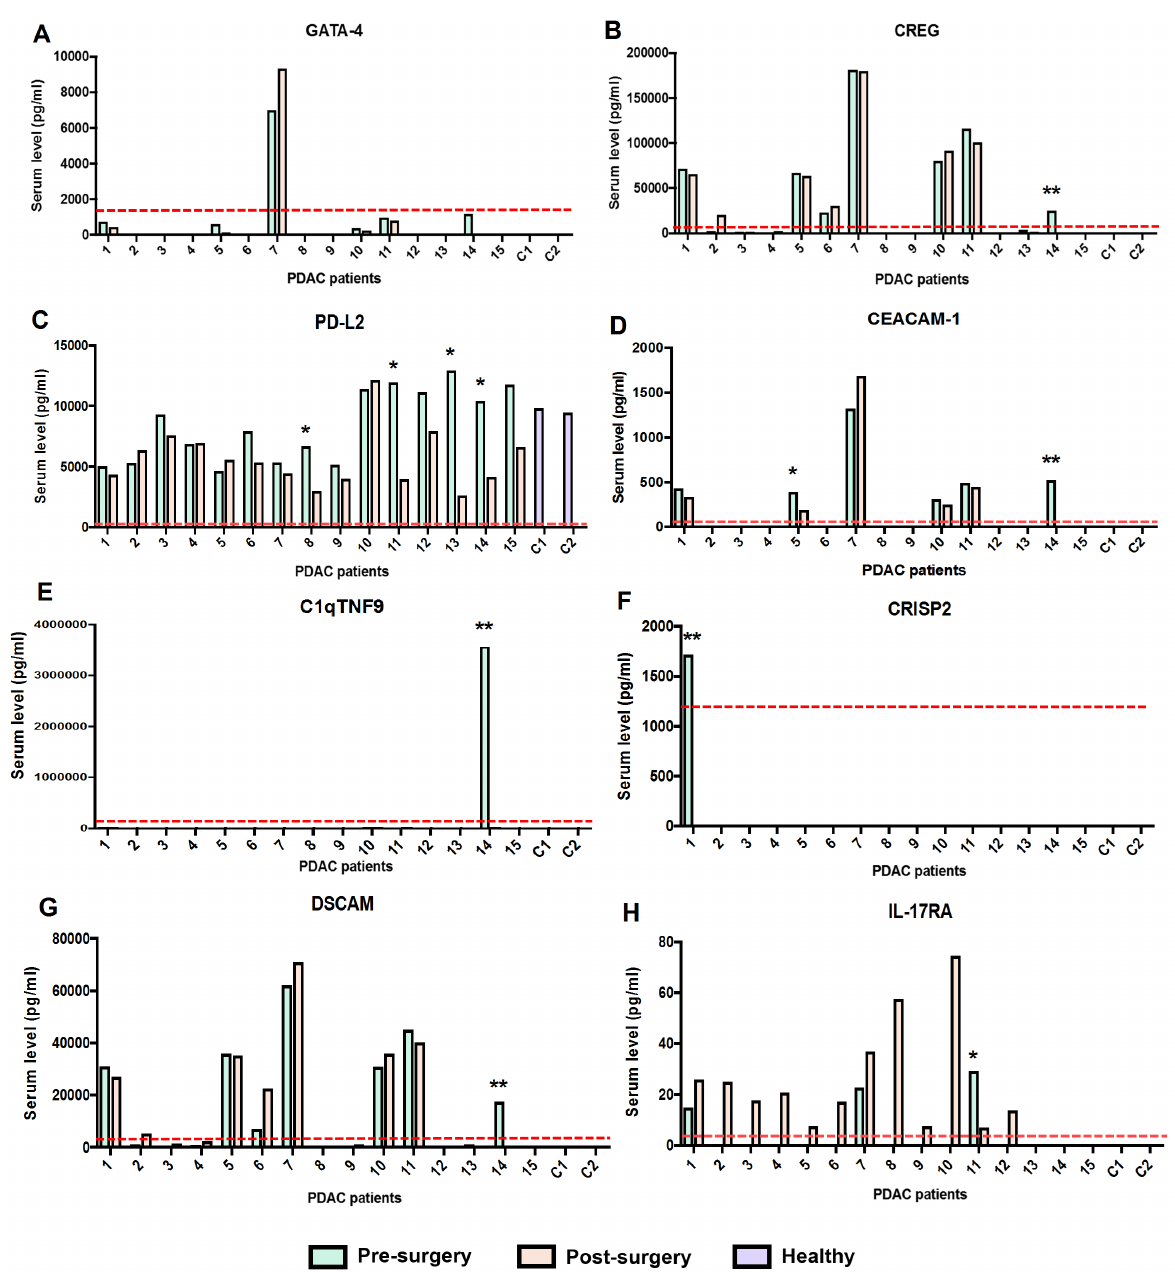
Figure 5. Validation of proteins that decreased in serum level in pancreatic cancer (PDAC) patients using single target ELISA assays. Bar graphs depict serum level of the proteins in fifteen PDAC patients (P1-P15), before and after surgery, and in two controls (C1 and C2). Red dashed line depicts limit of detection. * Post-surgical decrease of at least two-fold. ** Protein level dropped to undetectable level following